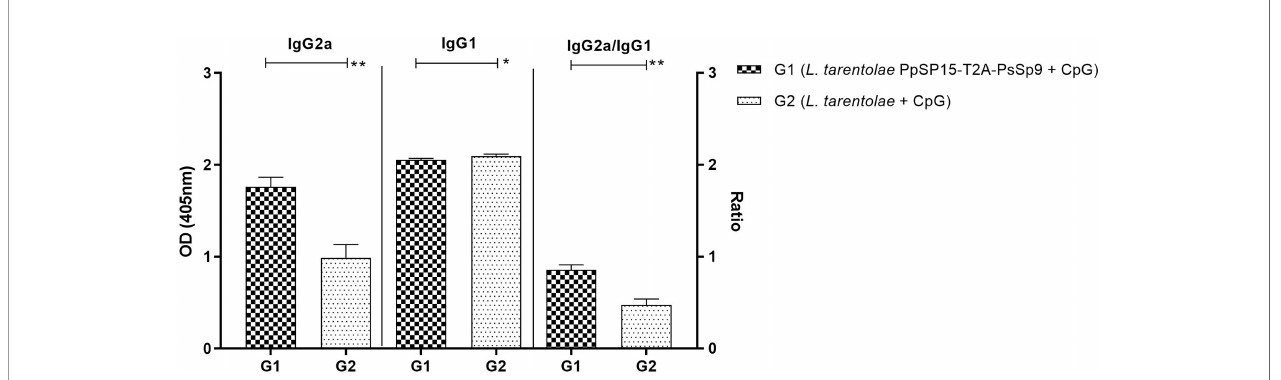
FIGURE 3 | Analysis of antigen-speci fi c antibody responses in vaccinated and control mice by ELISA before challenge. After the last immunization and prior to infectious challenge, four mice per group were bled from the venous sinus to collect sera. The level of IgG2a, IgG1, and IgG2a/IgG1 ratio were evaluated in response to L. tarentolae PpSP15-T2A-PsSP9 F/T antigen. Data are representative of two independent experiments. The results are presented as mean ± SE and student t- test was used for statistical analysis (* p < 0.05; ** p